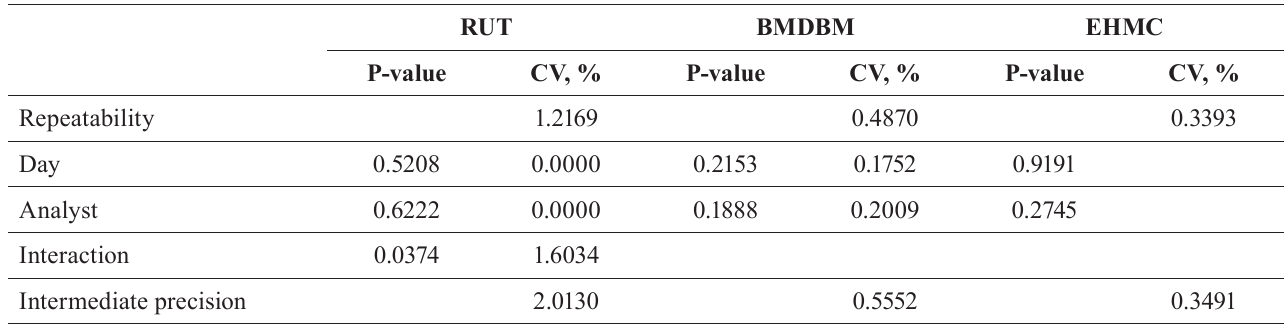
TABLE V - P -values obtained from the Analysis of Variance (ANOVA) and values of coefficient of variation for the day, analyst, and interaction factors ( α =